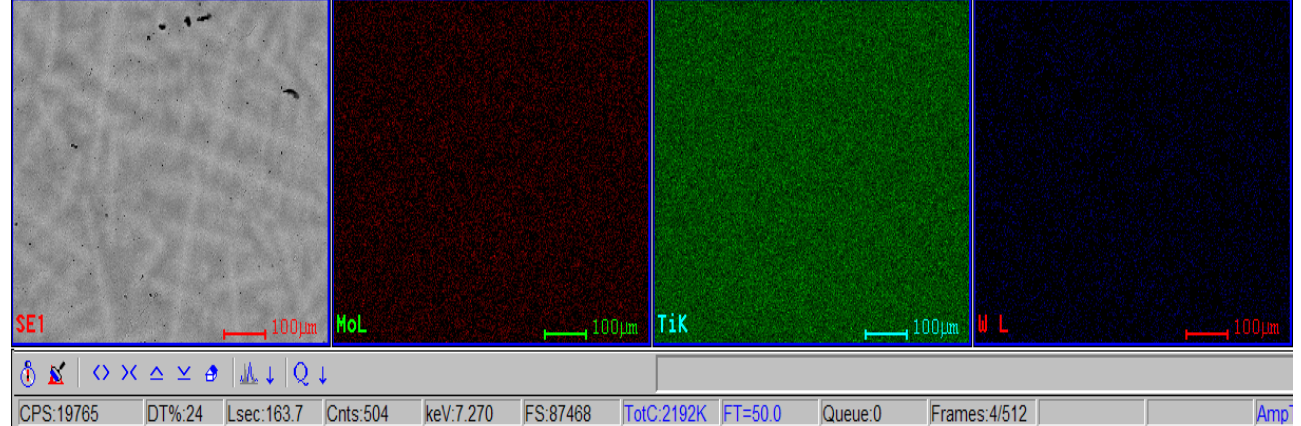
Figure 5. SEI image and BSED mapping of the Ti19Mo7W sample (Code 1) showing the repartition of W, Mo, and Ti.